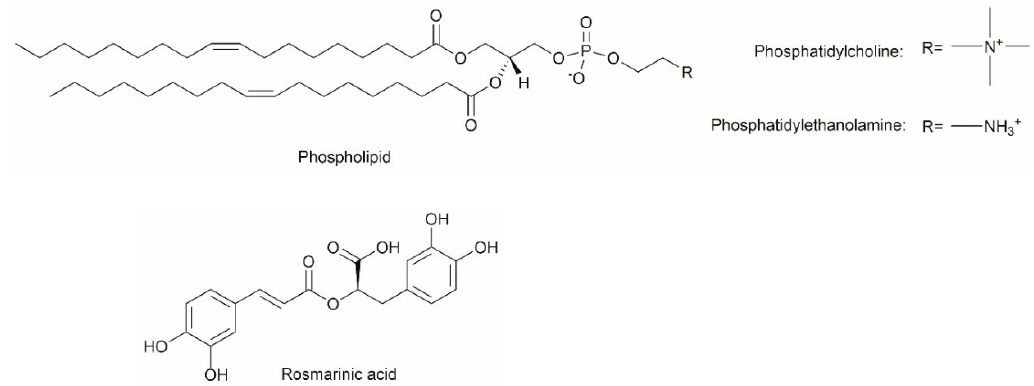
Figure 1. Chemical structures of phospholipid and rosmarinic acid.